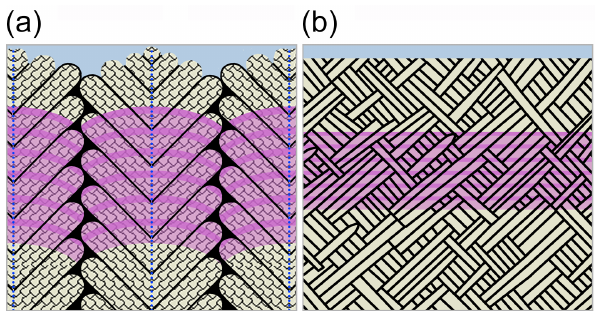
Figure 8. Schematic (not to scale) of the compound composite pris- matic (oOSL, a ) and crossed-acicular architecture (iOSL, b ; mod- ified after Bandel, 1977) transected by Sr labels (purple) summa- rizing the observations in this study. Unlabelled aragonitic archi- tectural units (beige) are outlined by organic sheaths (black). First- order prisms in (a) have thick organic sheaths, curved growth fronts, and consist of second-order prisms that are arranged at ca. 60 ◦ to the central axis of each first-order prism ( a , dashed blue lines). Third- order prisms ( a , tiled pattern) are oriented parallel to each other within second-order prisms. The shading in the pink Sr labels illus- trates the internal BSE greyscale variations in the Sr labels reflect- ing variable Sr concentrations within the Sr label in the shells. The Sr label is generally wider in the oOSL compared to the iOSL and transects all architectural units in both